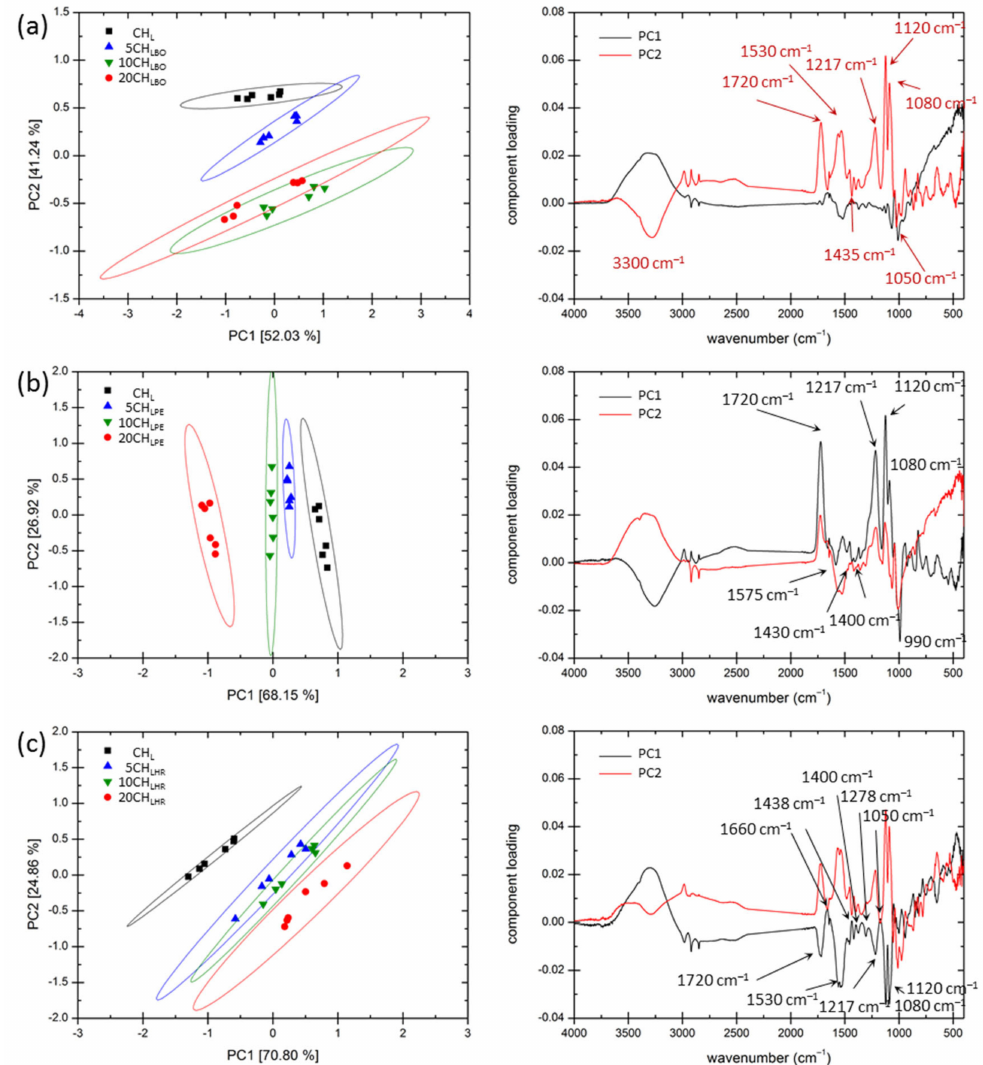
Figure 2. Results of Principal Component Analyses of the sets of packaging films prepared without and with various content of: ( a ) blueberry extract, ( b ) parsley extract, and ( c ) red grapes extract. The PCA was performed with all measured spectra (6 for each of the films). The value in the square bracket represents the relative variance that is composed in the respective principal component. Ellipses represent the 95% interval of